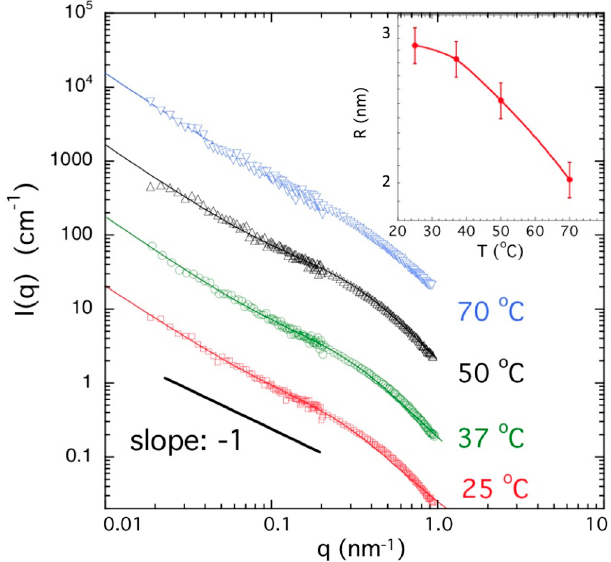
Figure 5. Small angle neutron scattering (SANS) profiles of 0.5 mass % gelator samples at different temperatures. For clarity, the SANS curves are shifted by a factor of 10 with increasing T . The continuous lines through the data points are least squares fits of Equation (1). The inset shows the variation of the cross-sectional radius R with T . Error bars correspond to one standard deviation.